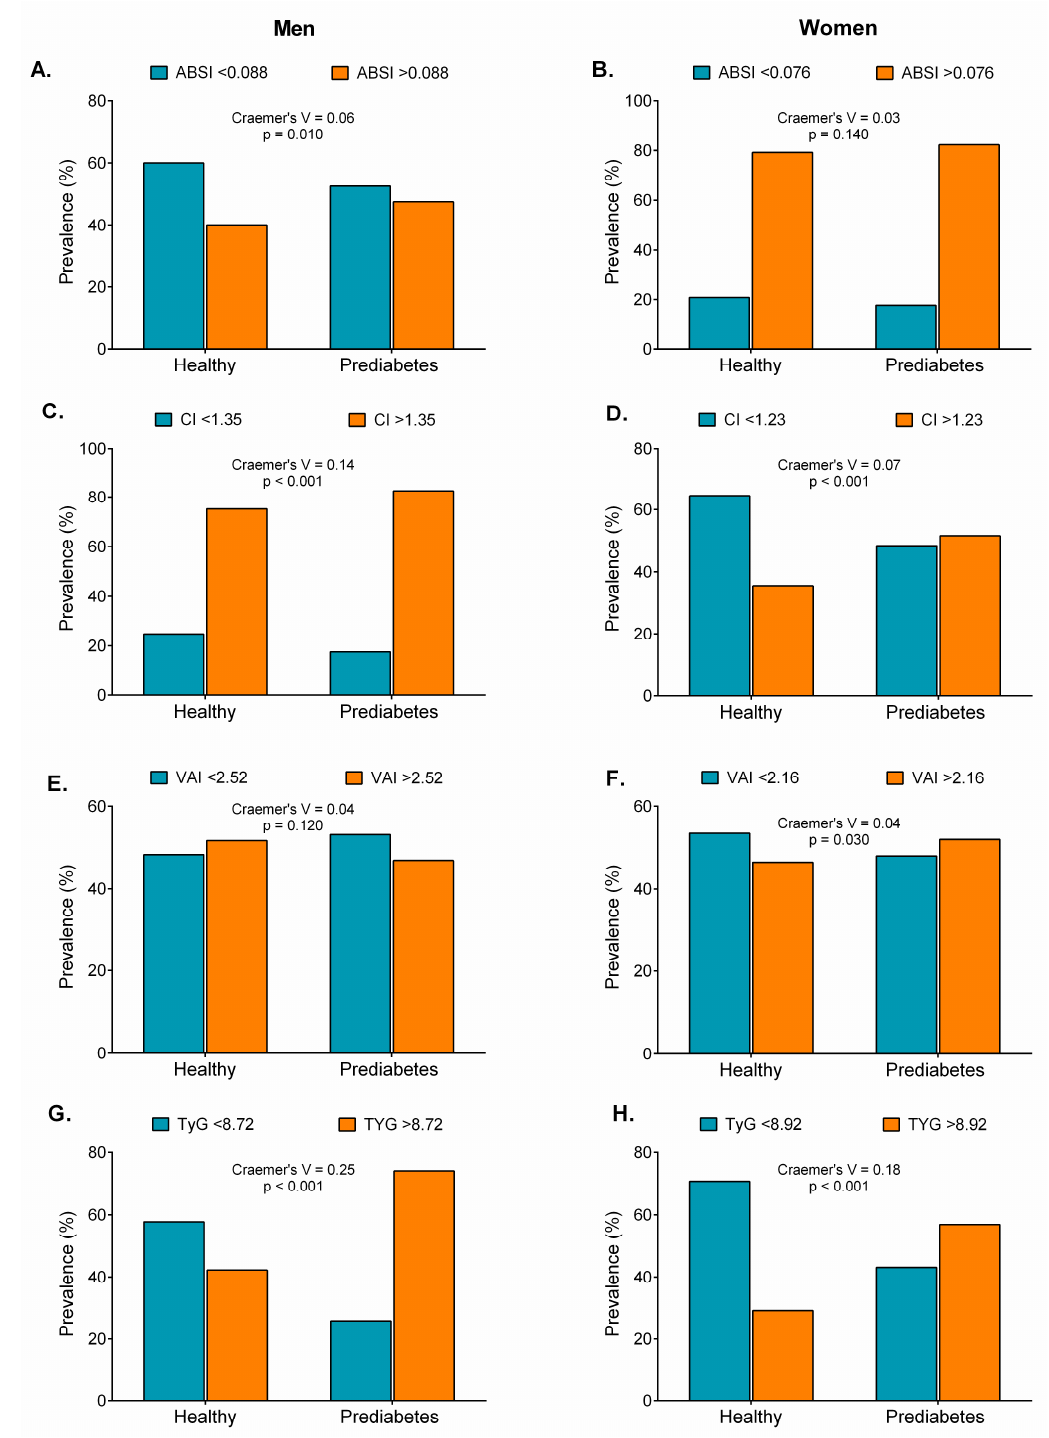
Figure 9. Prevalence of prediabetes according to obesity- and lipid-related index cut-offs (ABSI, C, VAI, and TYG).